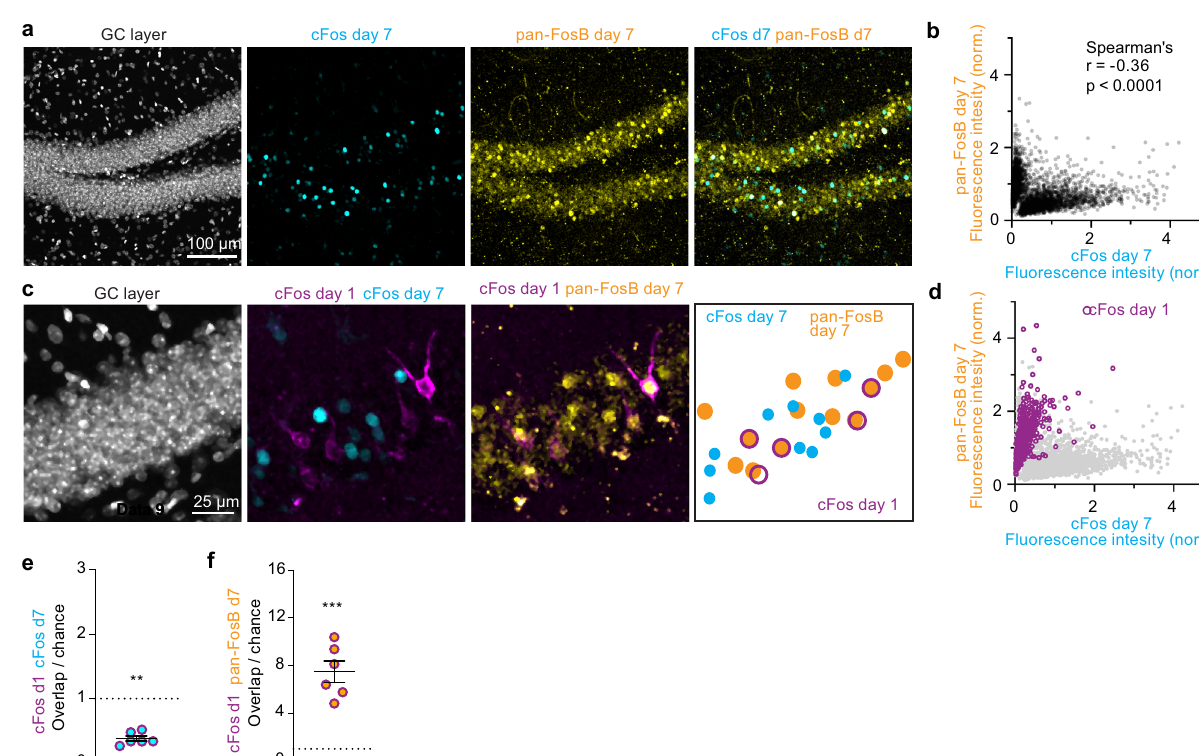
Fig. 6 | Mechanism of cFos suppression in WM-trained mice. a Immunostained hippocampal slice from the DG region against shEGFP (cFos, cyan) and pan-FosB mice (yellow) from mice that received daily training in the water maze for 7 days (fromoptogeneticexperiments,Fig.3). b Quanti fi cationofcFosandFosB/pan-FosB expression levels in individual granule cells (GC). GCs appear to be segregated in two clusters, resulting in a signi fi cant inverse correlation (**** p <0.0001, n =4111 GCs from three mice, Spearman ’ s r =0.36). c Same tissue section as a , showing cFos day1 (magenta), cFos day7 (cyan), and pan-FosB day7 (yellow) immunoreactive